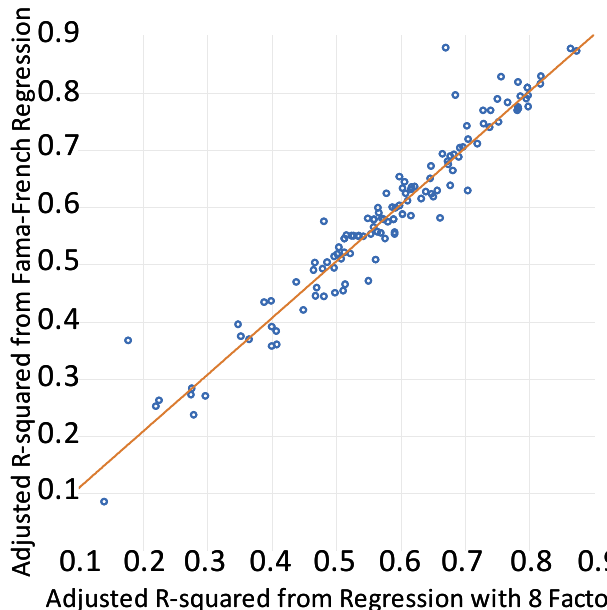
Figure 2. Adjusted R-squared coefficients from regressions with eight macroeconomic factors versus adjusted R-squared from regressions with five Fama and French factors. Note: The horizontal axis plots the adjusted R-squared coefficients from regressing daily returns on 125 sectors on the return on the aggregate U.S. stock market index, the return on the world stock market index, the change in the Federal Reserve broad trade-weighted dollar exchange rate index, the change in the log of the spot price for West Texas Intermediate crude oil, the change in the breakeven inflation rate calculated from U.S. Treasury inflation-protected securities, the change in the interest rate on three-month Treasury securities, the change in the spread between interest rates on ten-year and three-month Treasury security, and the change in the spread between interest rates on Moody’s seasoned Baa corporate bonds and ten-year Treasury securities. The vertical axis plots the corresponding adjusted R-squared coefficients from regressing daily returns on 125 sectors on the five Fama and French (2015) factors. These factors are (1) the return on the aggregate U.S. stock market index minus the return on one-month Treasury securities, (2) the average return on nine small capitalization stock portfolios minus the average return on the nine large capitalization stock portfolios, (3) the average return on two high-book value to market value portfolios minus the average return on the two low-book value to market value portfolios, (4) the average return on two robust operating profitability portfolios minus the average return on two weak operating profitability portfolios, and (5) the average return on two conservative investment portfolios minus the average return on two aggressive investment portfolios. Source: Datastream database, Federal Reserve Bank of St. Louis FRED database, homepage of Professor Kenneth French, and calculations by the author.